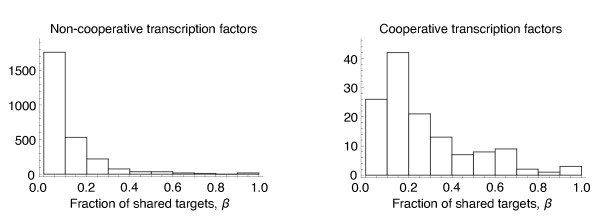
Number of shared targets. Fraction of targets that are shared between pairs transcription factors in S. cerevisiae[26-28]. (left) The fraction of targets that are shared among paris of transcription factors that lack cooperative binding and (right) the fraction of targets that are shared among transcription factors that bind cooperatively. The fraction of targets that are shared is larger among cooperative factors (p < 2×10−16, Wilcoxon test).